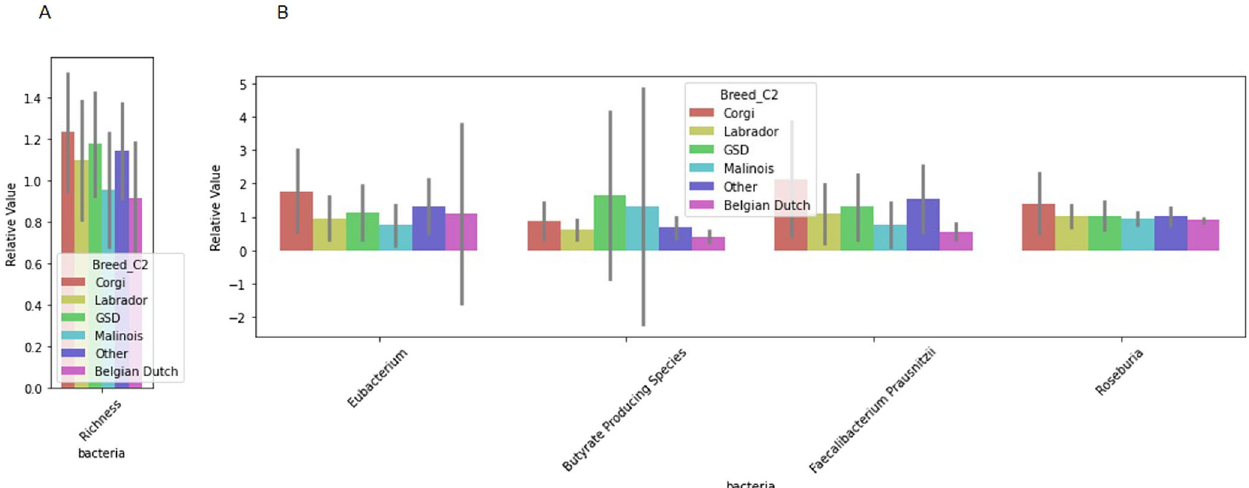
Fig. 3 Relative value of microbiome features that differed by canine breed group and are statistically signi fi cant (only associations signi fi cant via by Kruskal test, p < 0.05, are included). A Re fl ects differential value of richness and diversity, and B re fl ects relative abundance. Error bars represent con fi dence intervals. *GSD German Shepherd